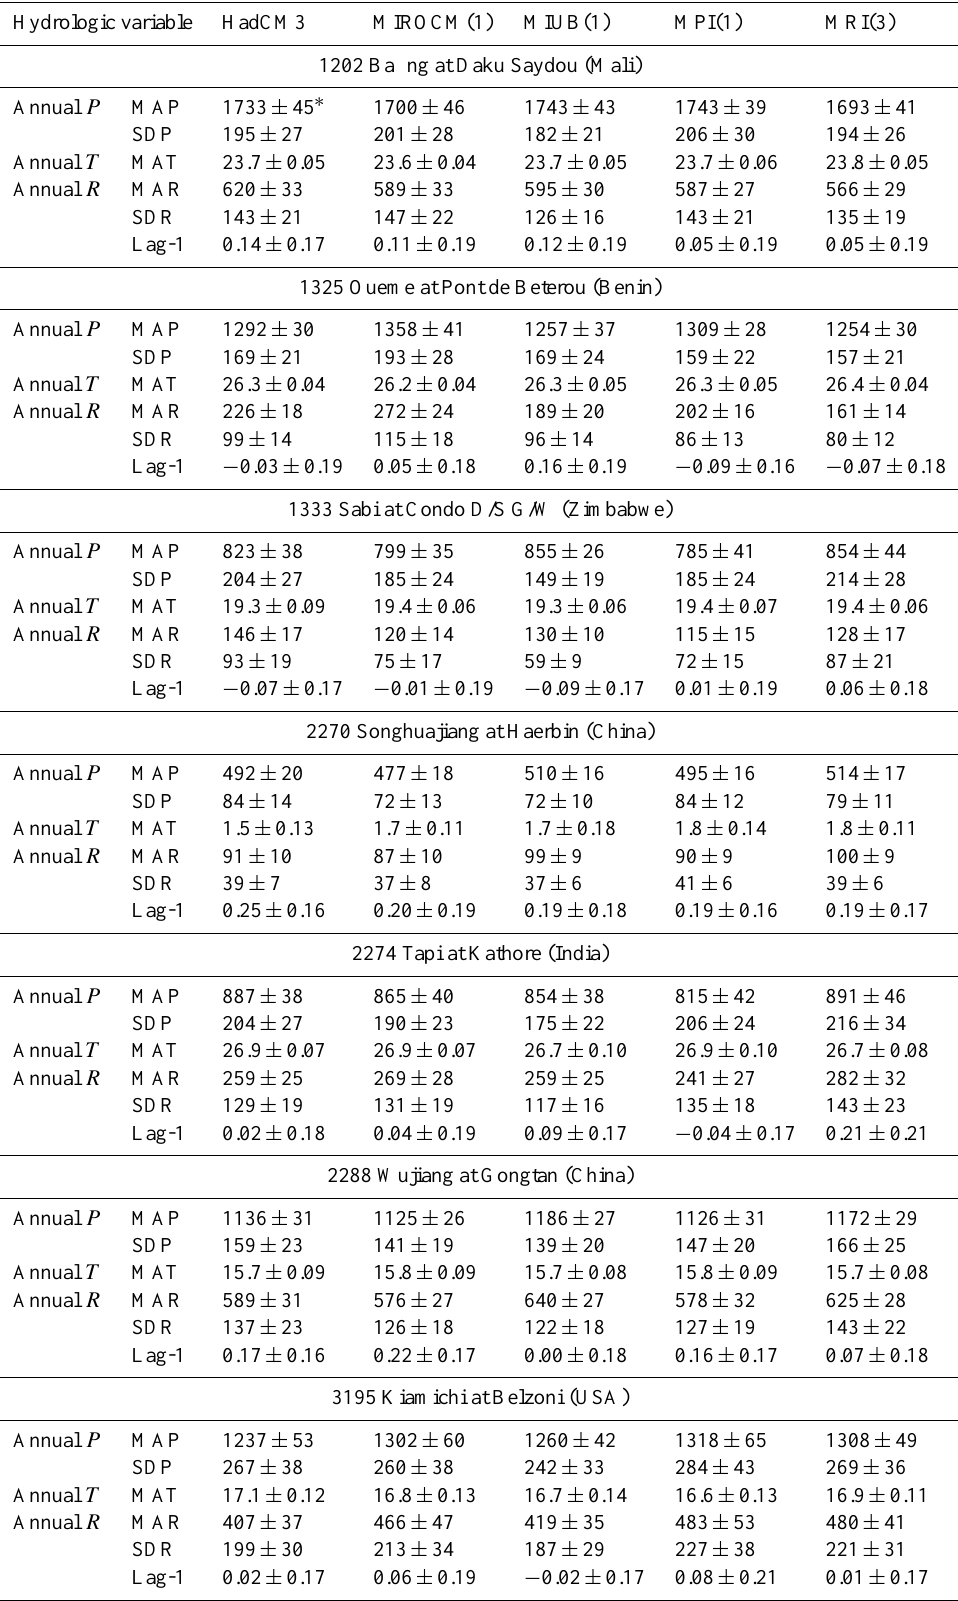
Table 4. Variation and uncertainty in key hydrologic statistics for the five highest ranking GCMs and 17 catchments, based on 100 replicates of de-trended 20C3M for the period